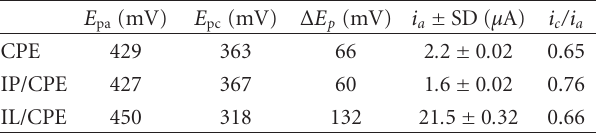
Figure 5: Di ff erential pulse voltammograms of rutin on IP/CPE (a), CPE (b), and IL/CPE (c). 0.008 mM rutin solution in acetate bu ff er (pH 4.0), scan rate 20mVs − 1 , pulse amplitude 50 mV, and pulse width 100 ms. Table 1: Potentials of anodic ( E pa ) and cathodic ( E pc ) peak (versus Ag/AgCl, 1M KCl), peak separation ( Δ E p ), anodic peak current ( i a , the average from seven repeated measurements, standard deviation SD) and ratio of cathodic to anodic peak current ( i c /i a ) of 0.1 mM rutin at the para ffi n/graphite (CPE), para ffi n/iron- phthalocyanine/graphite (IP/CPE) and [hmim][Tf 2 N]/graphite (IL/CPE) electrodes (scan rate 100 mVs − 1